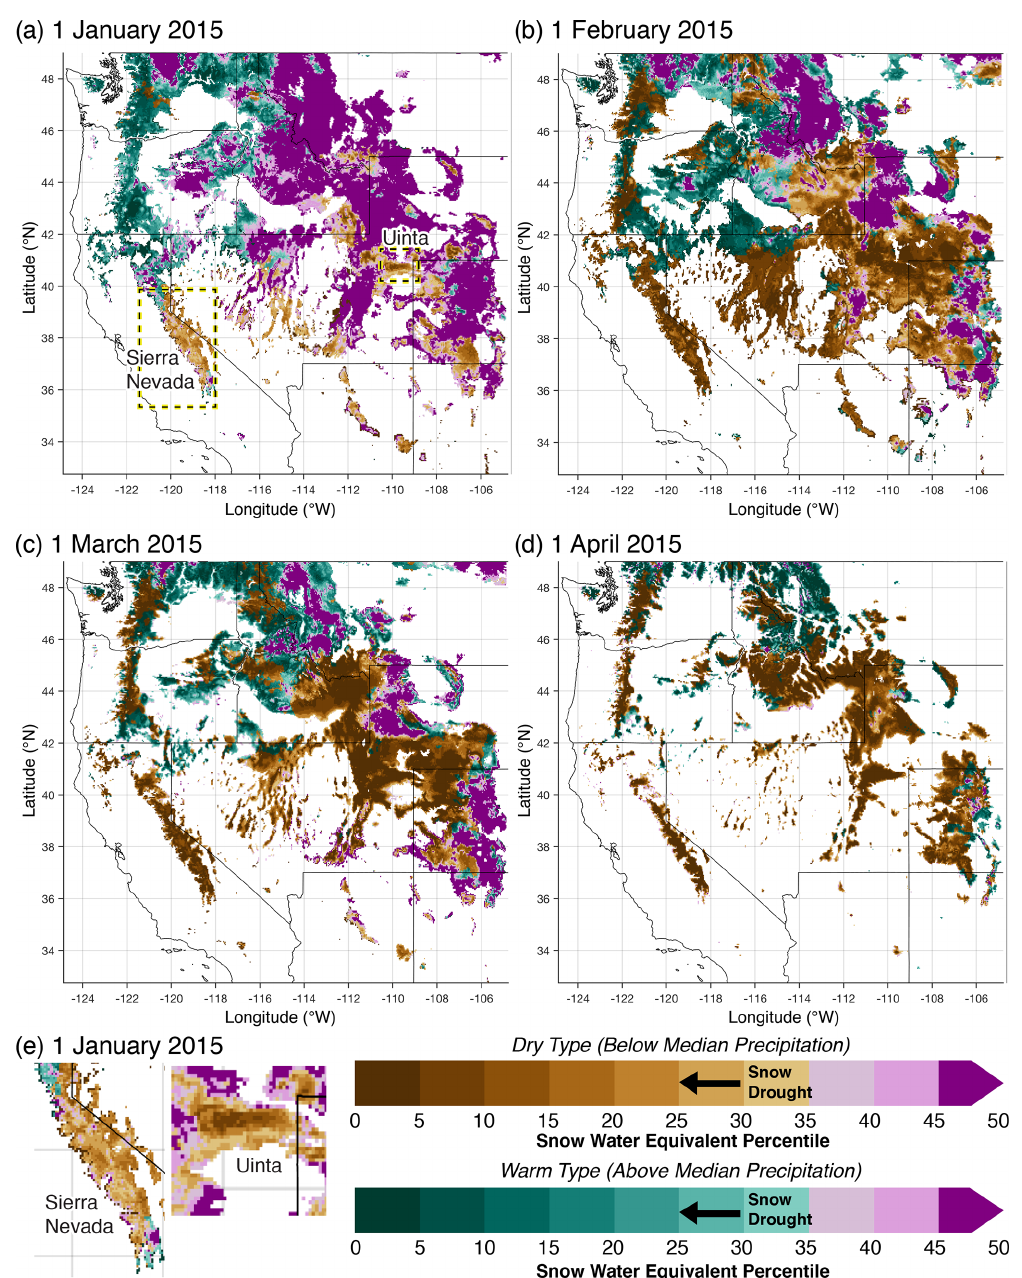
Figure 8. Spatial extent of snow drought conditions across the western United States on (a) 1 January 2015, (b) 1 February 2015, (c) 1 March 2015, and (d) 1 April 2015. (e) The differing snow drought patterns across elevation in the Sierra Nevada (percentiles increase with increasing elevation) and the Uinta Mountains (percentiles decrease with increasing elevation). For clarity, only grid cells observing seasonal snowpacks (Hatchett, 2021) are